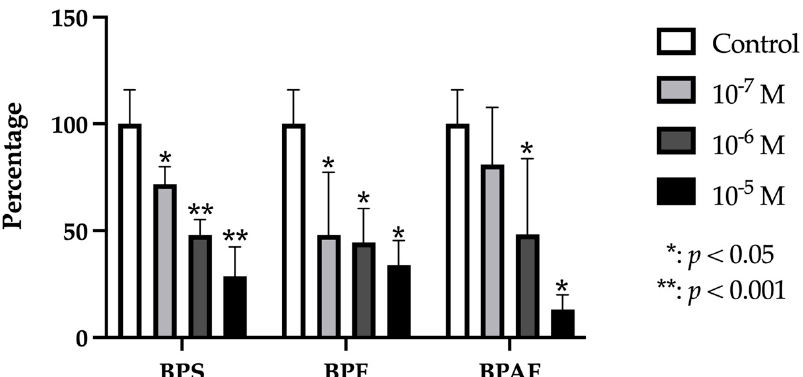
Figure 1. Expression of RUNX2 in primary human osteoblasts treated for 24 h with bisphenol S, F, and AF (10 − 7 , 10 − 6 , or 10 − 5 M). The assay was performed in triplicate with each of the three primary human osteoblast cell lines. Data are expressed as percentage expression with respect to control ± standard deviation. Significant differences * p < 0.05; ** p < 0.001.